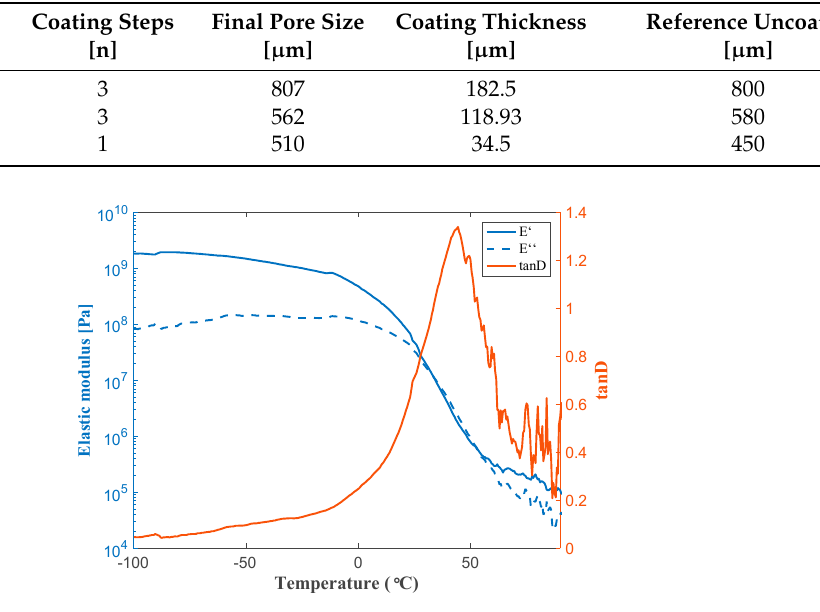
Table 1. Process conditions and geometrical parameters of the final set of internally coated foams used for aeroacoustic testing.